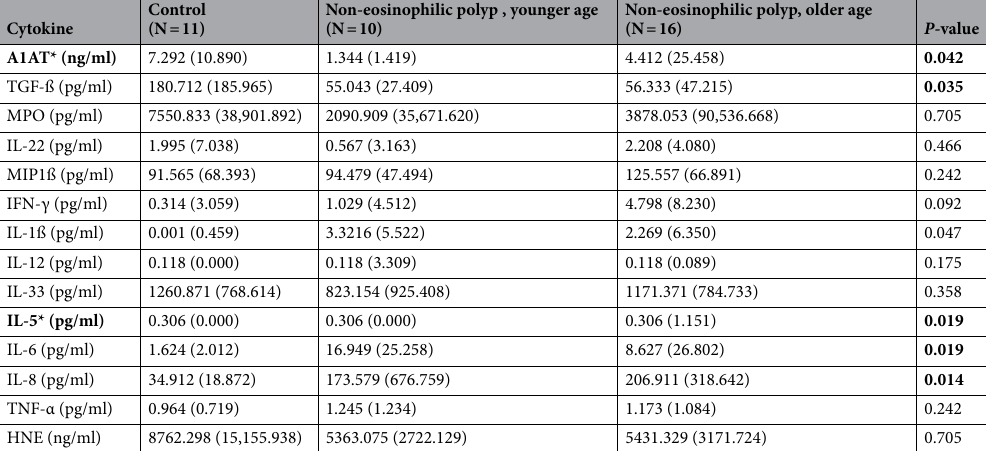
Table 2. Comparison of immunological characteristics of non-eosinophilic polyps with age under 35 years and over 35 years in cohort 2. Values are presented as medians with interquartile ranges (IQR). A1AT, alpha 1